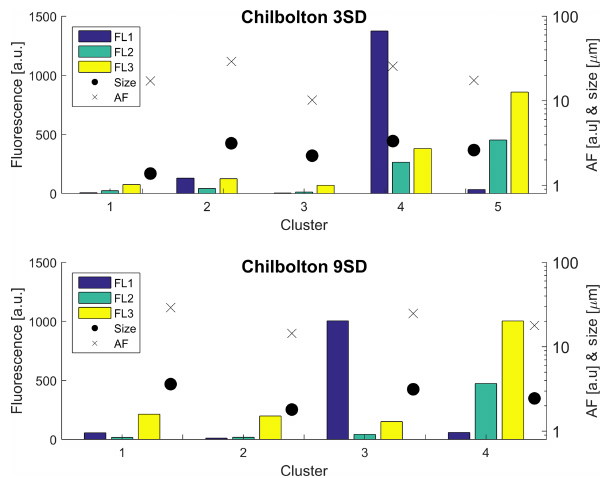
Figure 7. Sensitivity of the HAC threshold using 3SD and 9SD for analysis of the Chilbolton